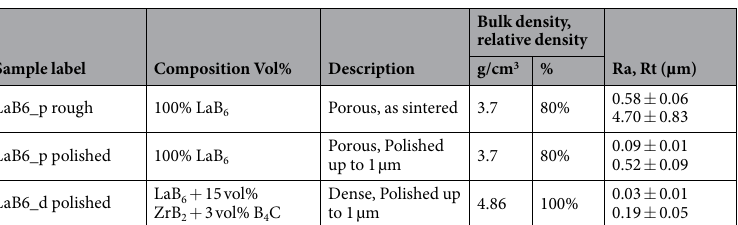
Table 1. List of materials, compositions, densities and surface roughness. The letter _p in the name stands for porous, while the suffix _d identifies the dense sample. R a : mean surface roughness; R t : distance between the highest asperity and the lowest